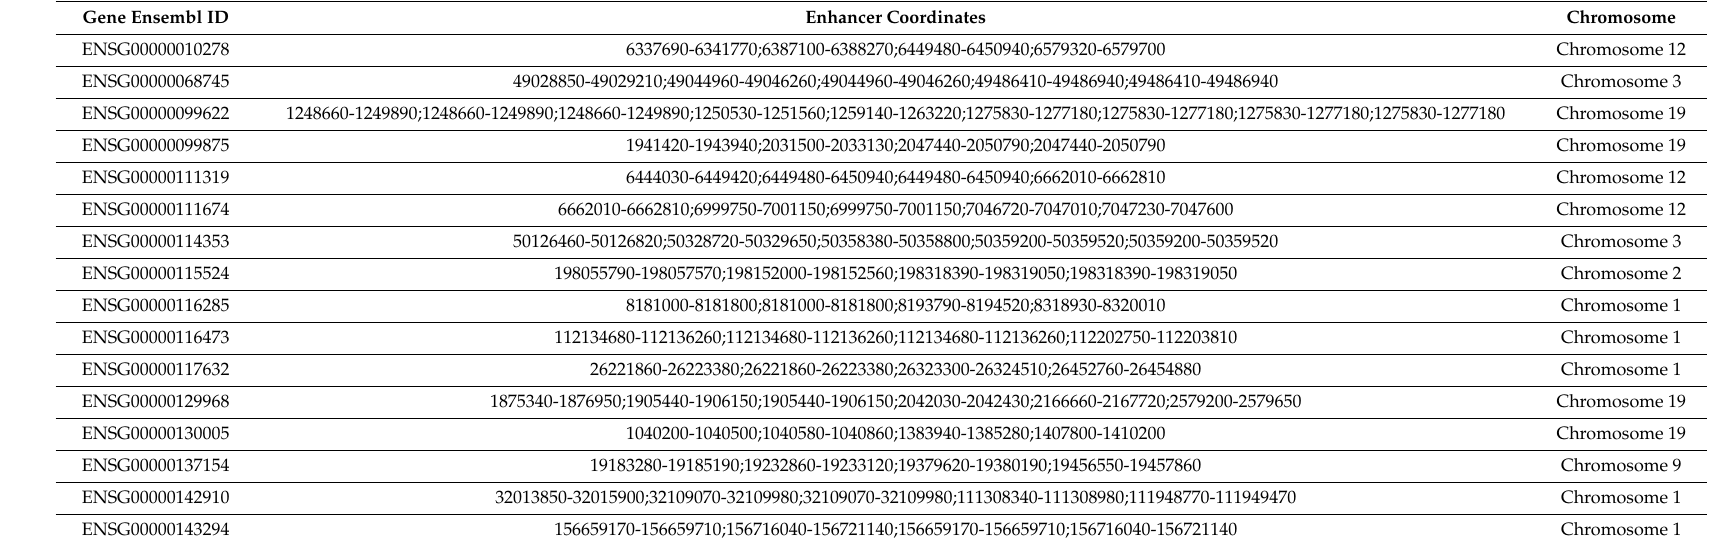
Table 3. Genes regulated by super enhancers, including name of the gene, the genome coordinates of its enhancers and name of the